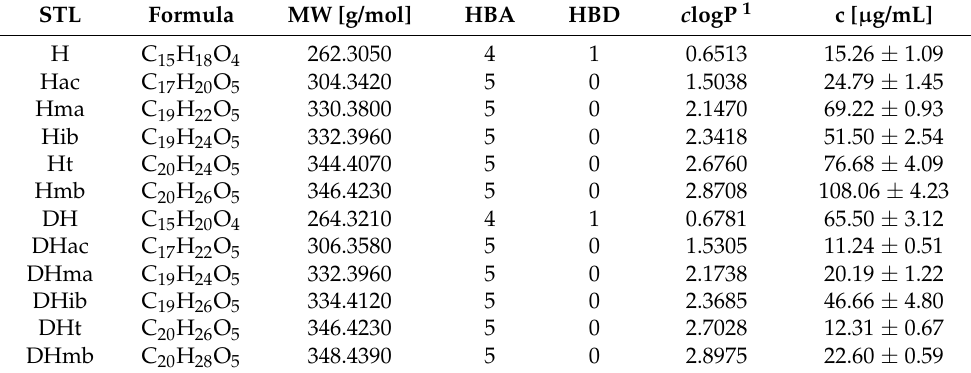
Table 1. STLs in the Arnica tincture under study: formula, MW, HBA, HBD, c logP values and concentrations quantified by UHPLC-HRMS ( n =